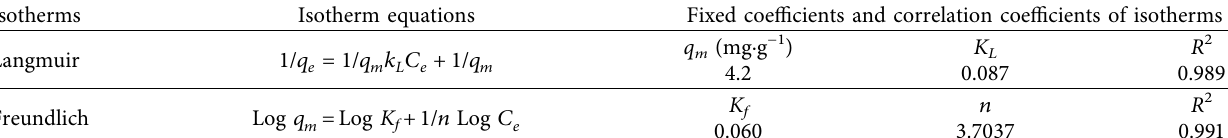
Table 7: Fixed and correlation coefcients of Langmuir and Freundlich isotherm models for NOM. Isotherms Isotherm equations